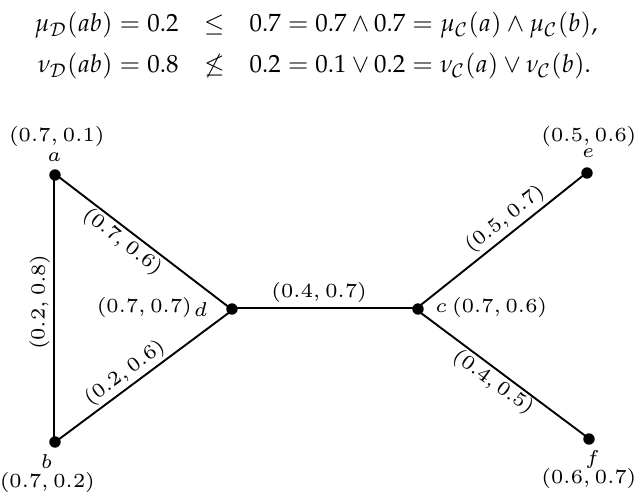
Figure 4.3: Direct Sum of two PFGs. Figure 18. Direct Sum of two